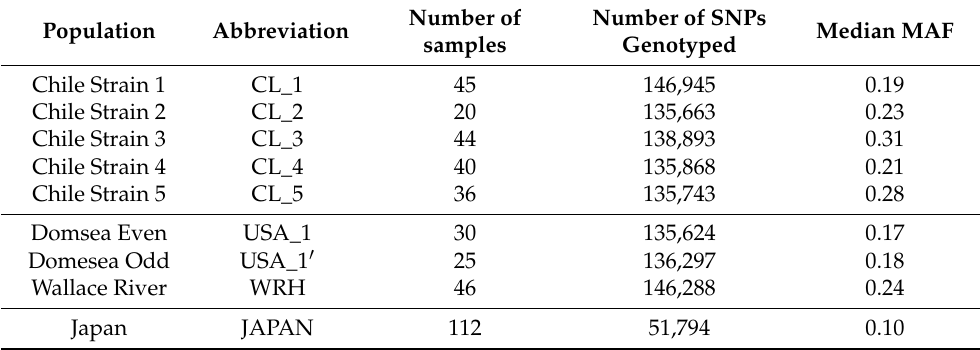
Table 1. Description of the SNP data obtained from the different populations analyzed. Sample size, number of SNPs genotyped, and the median minimum allele frequency (MAF). SNPs were derived from the Coho salmon microarray, except for the Japanese population, where SNPs were obtained from double digested Restriction-Site Associated DNA (ddRAD)